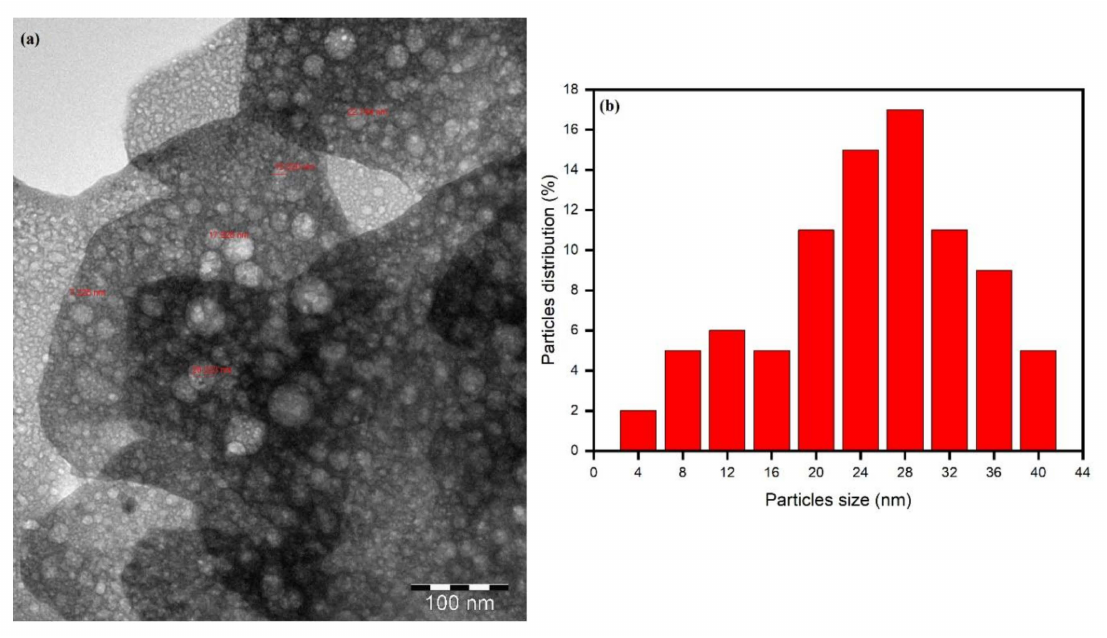
Figure 8. TEM image of optimized AgNPs ( a ) and AgNPs histogram showing the size distribution ( b ).